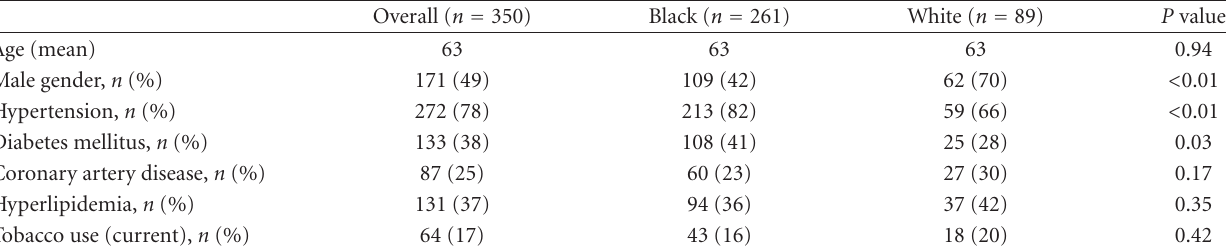
Table 1: Baseline characteristics of the cohort as a whole and by